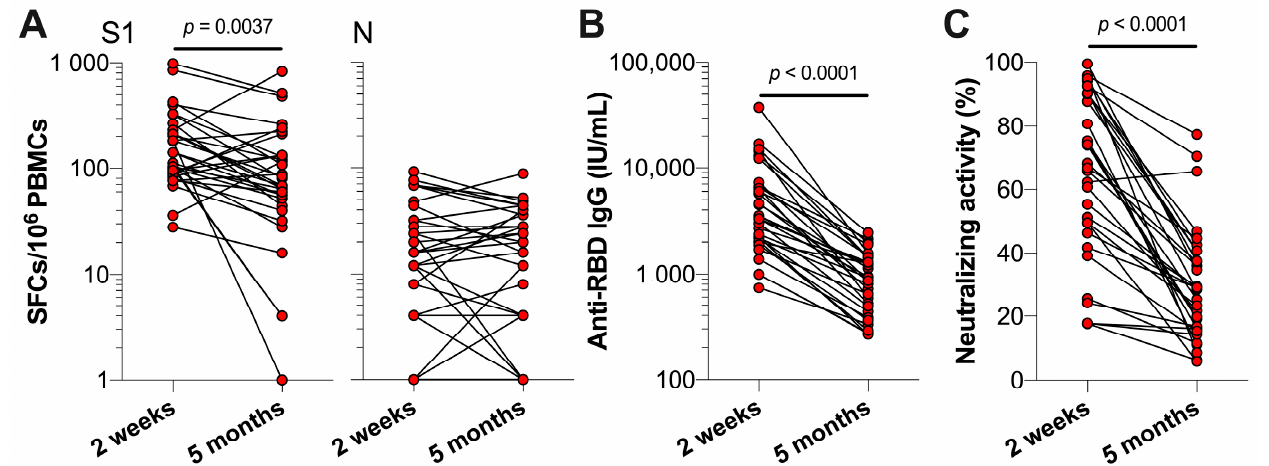
Figure 2. SARS-CoV-2-specific T cell and antibody responses of previously infected HCWs two weeks and five months post-primary vaccinations. Previously infected HCWs ( n = 32) are represented by individual data points. ( A ) T cell responses against SARS-CoV-2 S1 and N, ( B ) serum anti-RBD IgG concentrations, and ( C ) the neutralizing activity of serum antibodies against SARS-CoV-2 at two weeks and five months (i.e., t0) after primary vaccination series. Statistical significance was assessed with a Wilcoxon test.